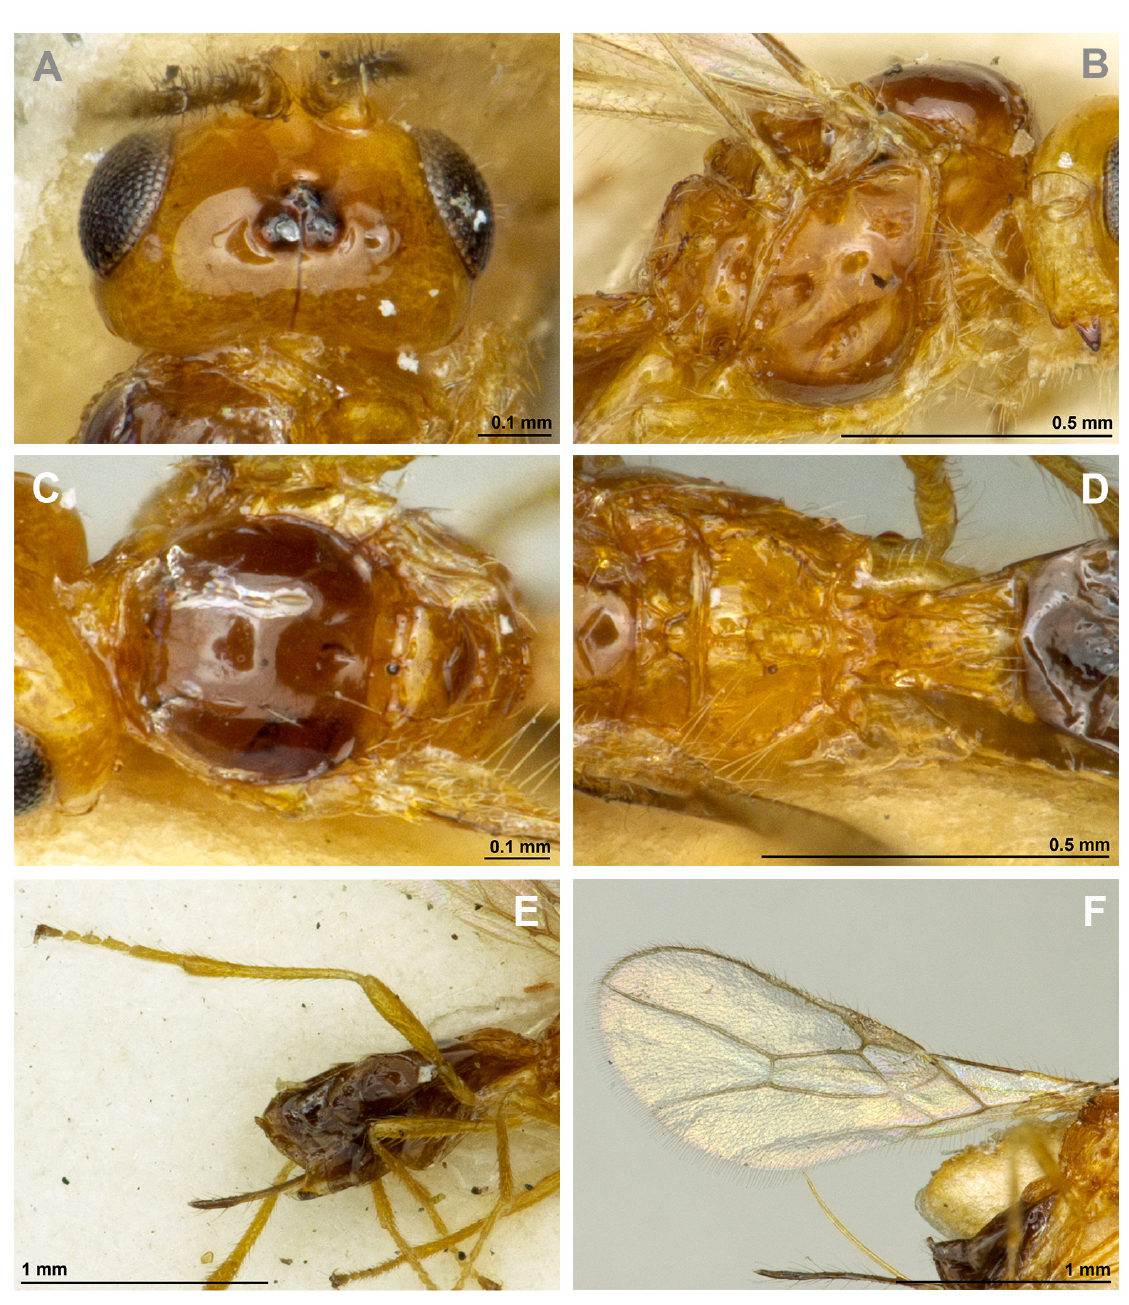
Fig. 55. Asobara sarae Peris-Felipo, sp. nov., ♀, holotype (BMNH 1922-25). A . Head, dorsal view. B . Mesosoma, lateral view. C . Mesoscutum, dorsal view. D . Propodeum and first metasomal tergite, dorsal view. E . Hind leg, metasoma and ovipositor, lateral view. F . Fore